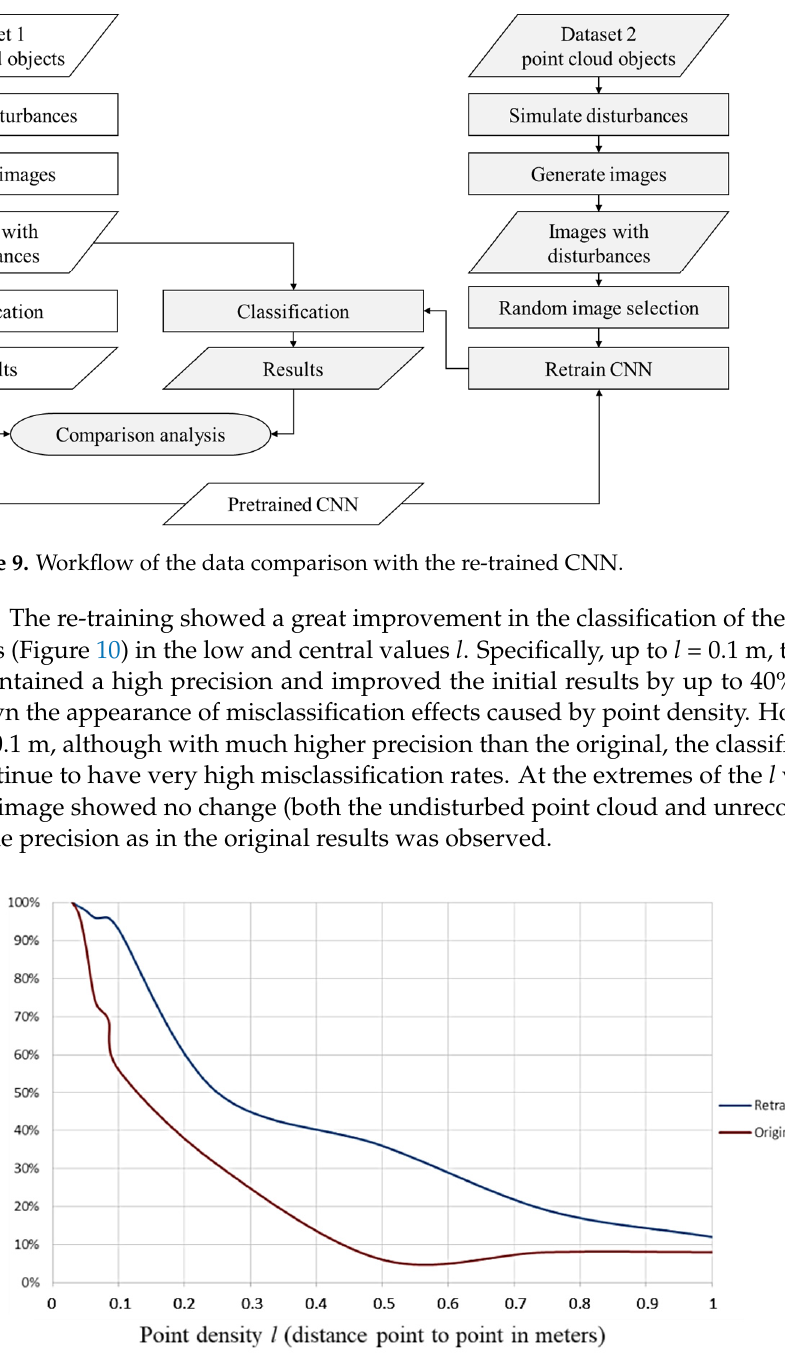
Figure 11. Comparison of precision of the re-trained and original CNN with noise level variation. Re-training with occlusions showed a turning point in the results obtained (Figure 12). Up to r = 1 m, the classification with small occlusions improved up to 10% and the misclassification effect was slowed down. However, from r = 1 m onwards, the reverse effect occurred, and the results worsened. This turning point is related to the size of the occlusion concerning the size of the object, as many small objects with occlusions of r = 1 m to 1.5 m started to occlude almost entirely. Applying occlusions of radius greater than r = 1.5 m, most of the objects that conserved information were the large ones, mainly pole- like objects. When these objects were partially occluded, the resulting sample was usually only a pole, which was very difficult to identify.